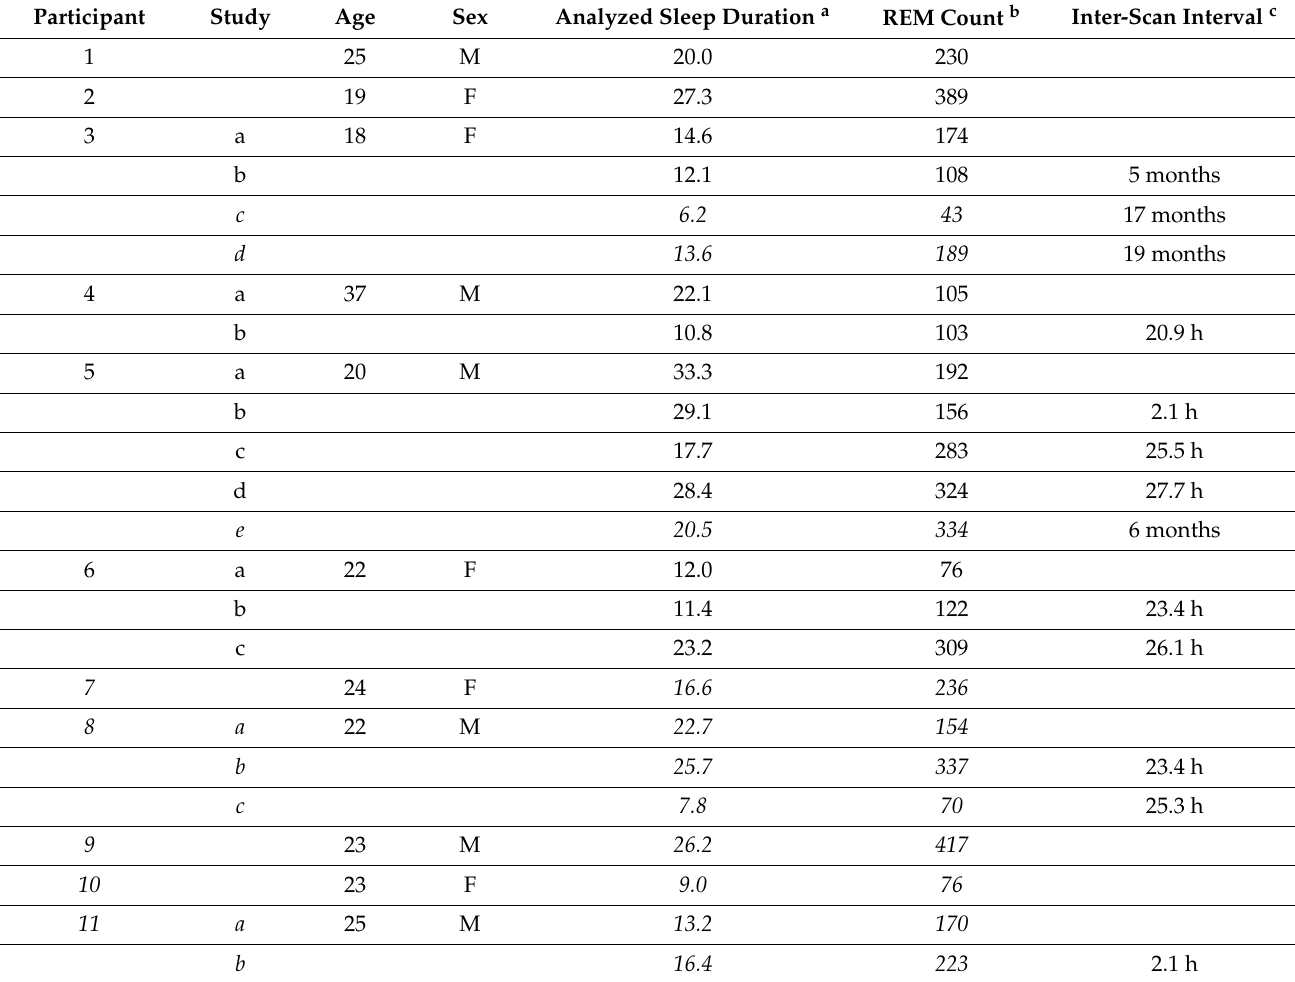
Table 1. Participant and REM